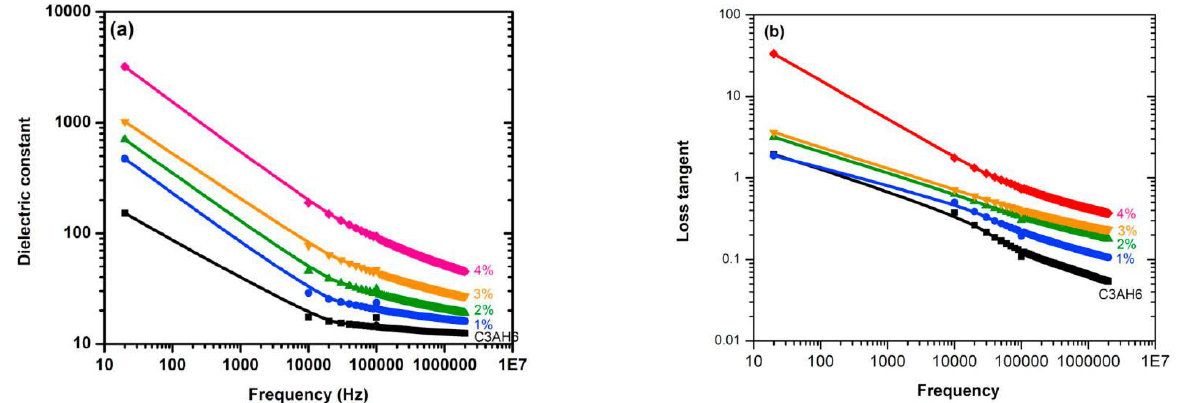
Figure 32. ( a ) Dielectric constant and ( b ) dielectric loss of CCMs with different concentrations of rGO. Reprinted with permission from Ref. [31]. Copyright 2019 Elsevier.